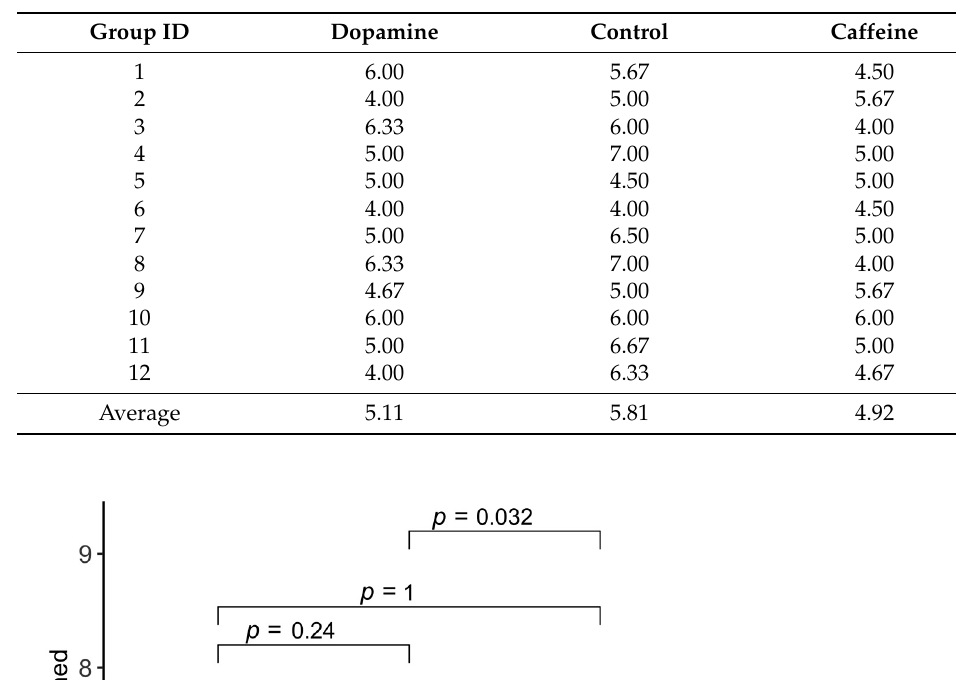
Table 1. Collated data from the 12 student groups. Values indicate the average number of trials required for conditioning response.